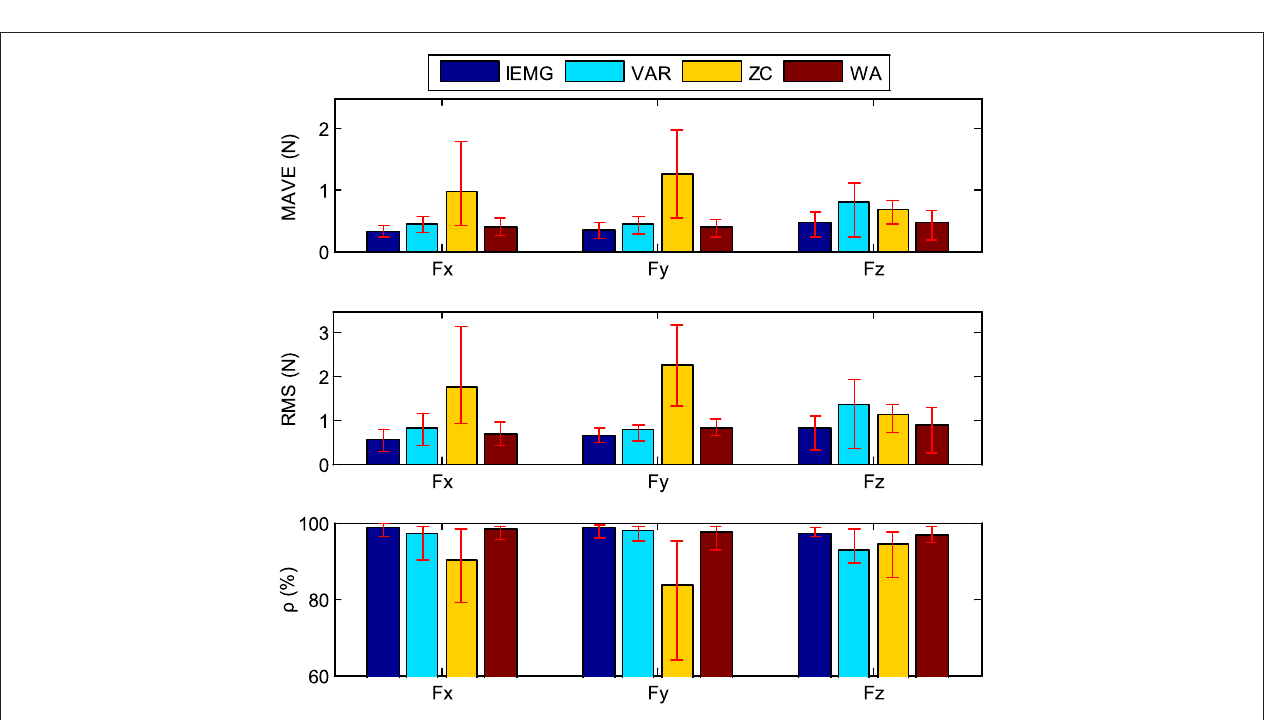
FIGURE 18 | The statistical results of the 3D force estimation experiments.